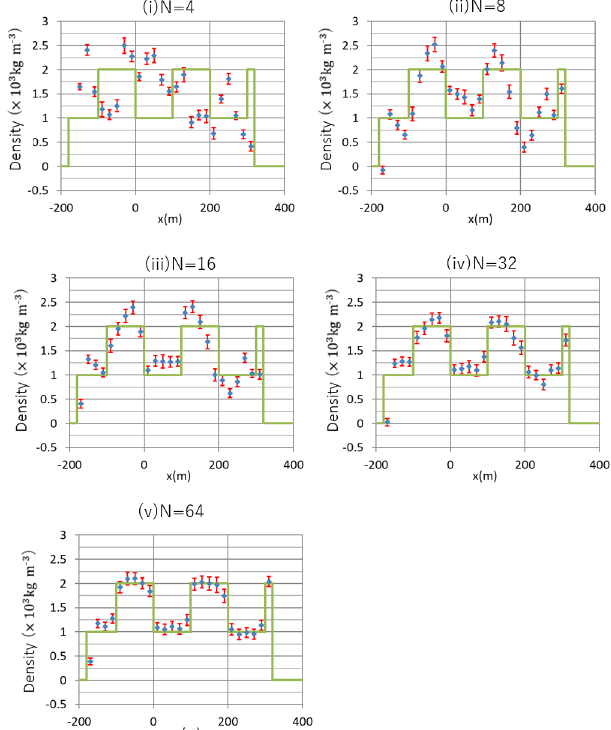
Figure 8. (C). Reconstruction results across z = 490m and y = 150m cross sections. The green lines represent the original im- age ( ρ ori (x,y = 150 ,z = 490 )) , the blue points represent the re- construction results with no accidental errors ( ρ rec (x,y = 150 ,z = 490 )) and the red error bar indicates the accidental errors ( δρ acc (x,y = 150 ,z = 490 ))